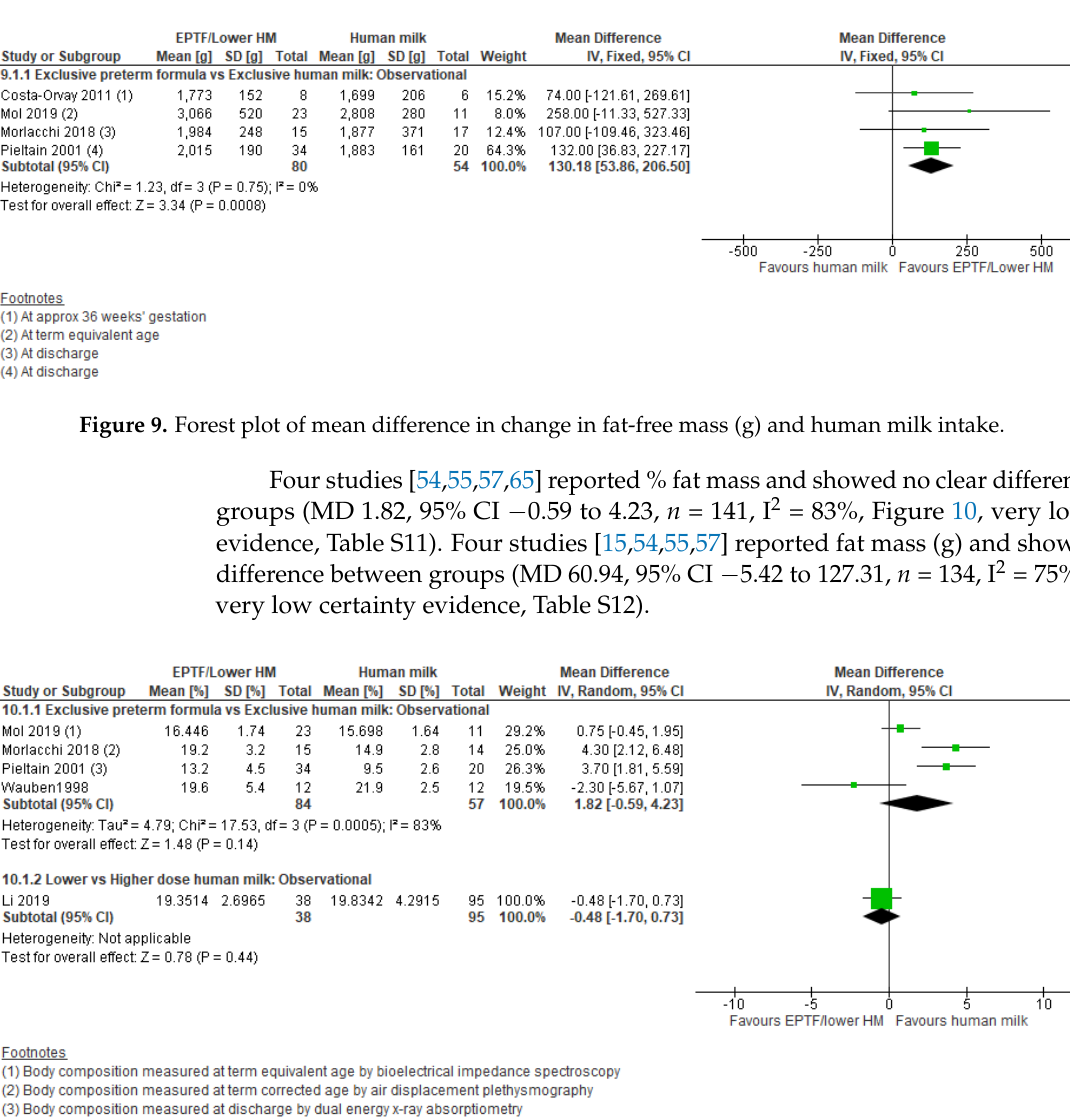
Figure 11. Forest plot of mean difference in change in fat mass (g) and human milk intake. Overall: The evidence for an effect of feeding EPTF vs. EHM on fat and fat-free mass is inconclusive.